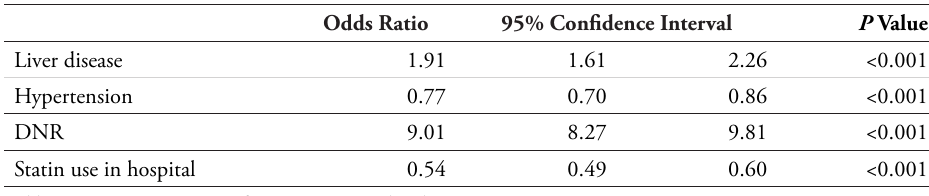
Table 4. Association of Risk Factors with Mortality